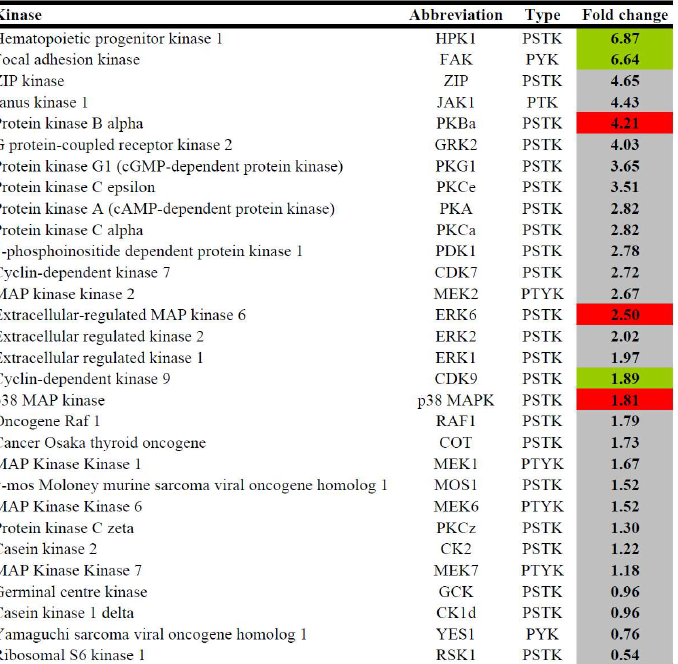
Figure A1. Effects of ten days of CrM supplementation in healthy young men (with no changes in their dietary intake) on protein kinase content using the Kinetworks KPKS 1.0 Protein Kinase screen. PSTK = protein–serine/threonine kinase; PTYK = protein–threonine/tyrosine kinase; PYK = protein–tyrosine kinase; PTK = protein–threonine kinase. Significant increases (red; p < 0.05), trends for increases (green; p < 0.09), and no change (grey) in protein content with CrM supplementation vs. placebo are indicated. Reproduced from Safdar et al. (2008).